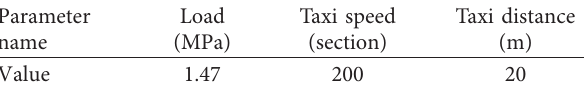
Table 4: Aircraft load parameters.